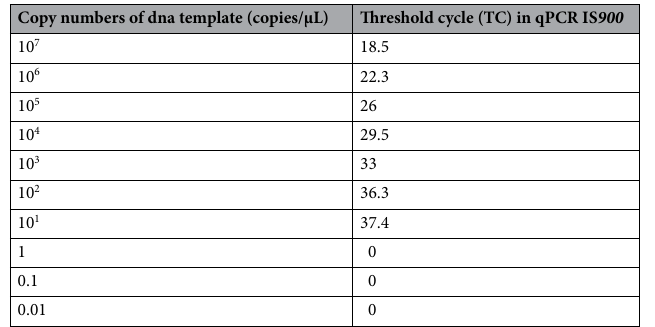
Table 5. Standardization of qPCR IS 900 analysis and threshold cycles (TC) corresponding to numbers of MAP copies in each reaction.